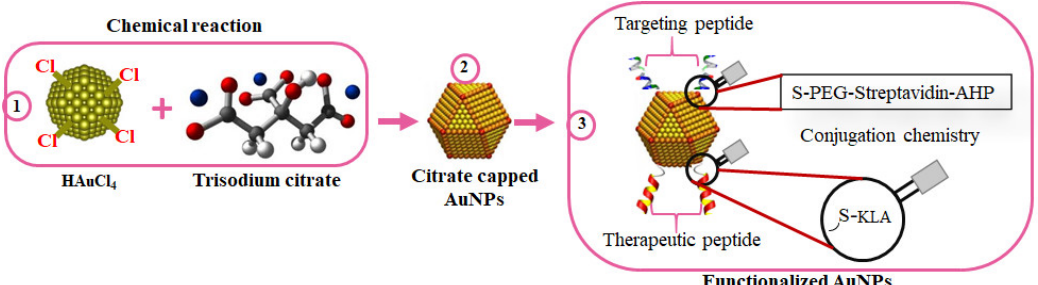
Figure 6. Surface chemistry of bifunctionalized citrate-capped AuNPs. AuNPs were chemically synthesized using trisodium citrate as the reducing agent (1); to form citrate-capped AuNPs (2); while exploring the AuNP-thiol affinity for the attachment of the targeting and therapeutic peptides (3).